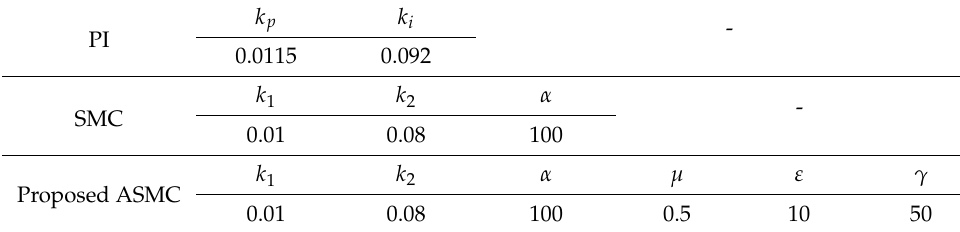
Table 2. Parameters of the three control